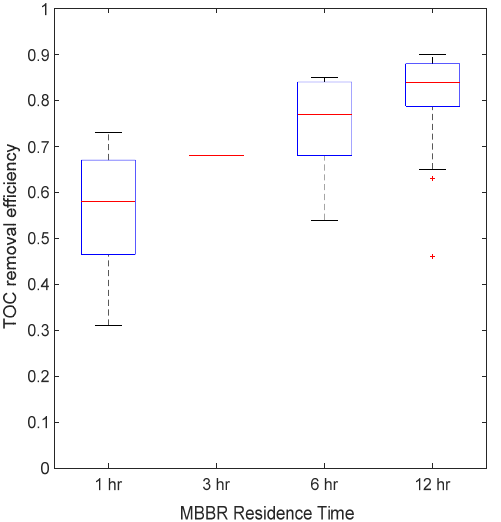
Figure 11. Average TOC removal efficiency versus MBBR residence time.